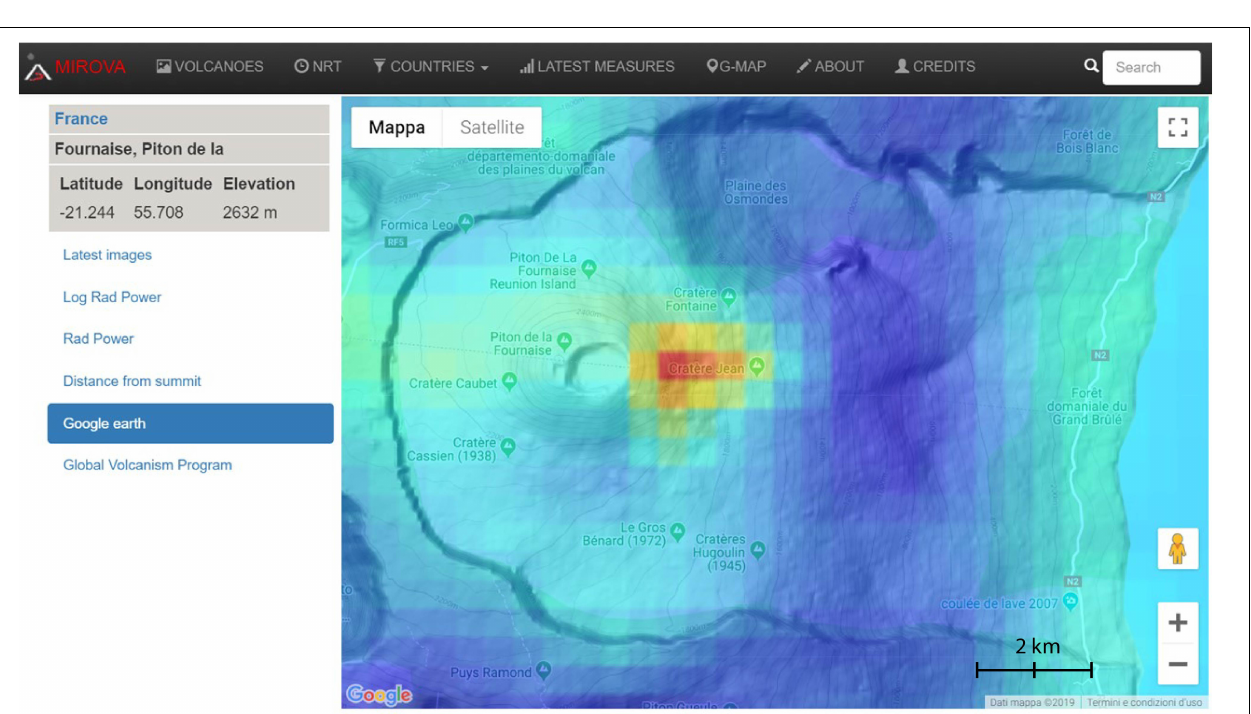
Frontiers in Earth Science |